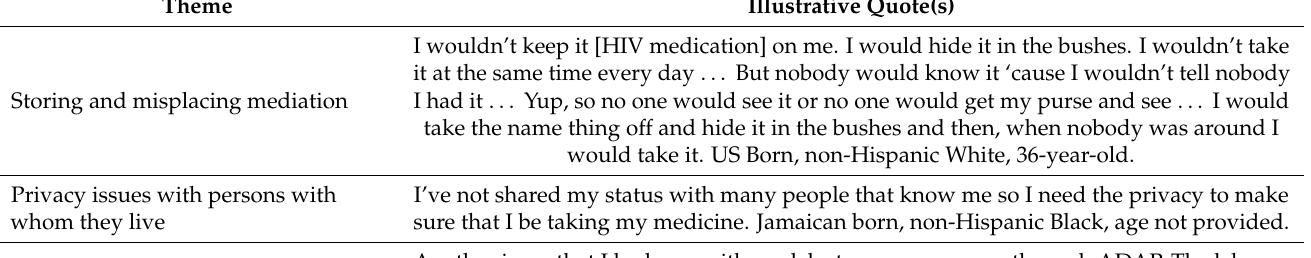
Table 3. Identified barriers for medication adherence and retention in care for women living in unstable